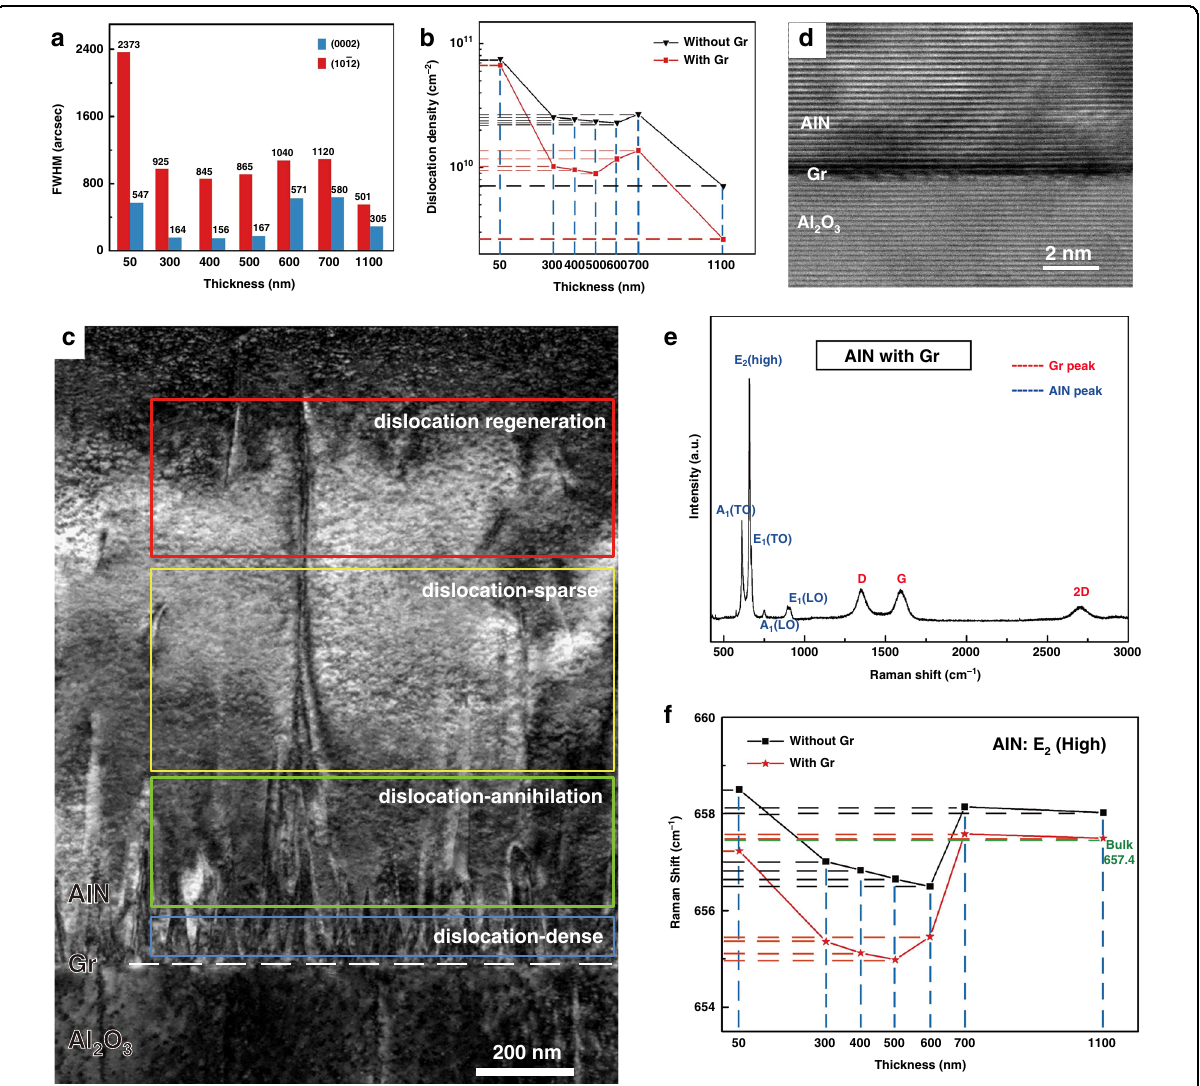
Fig. 3 XRC, TEM and Raman analyses for crystal quality of as-grown AlN fi lm. a FWHMs of (0002)- and (1012)-plane XRCs of AlN epilayer with various thicknesses grown on Gr-buffered sapphire. b Estimated DD of the AlN fi lms with and without Gr buffer layer with various thicknesses. c DF images of epitaxial AlN/Gr/sapphire with g = [0002]. d HRTEM image of the AlN/Gr/sapphire interface. e Raman spectra of as-grown AlN/Gr/sapphire structure. f Relative Raman shifts of E 2 (high) of AlN with various growth